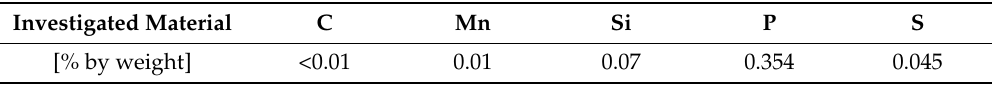
Table 1. The chemical composition of the tested steel (in % by weight).